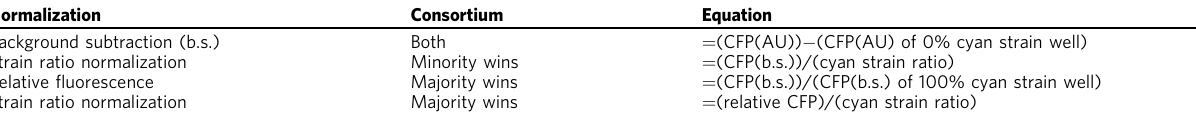
Table 1 Normalization